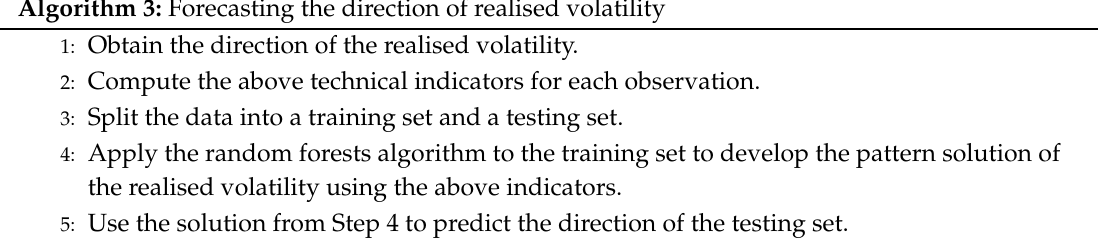
Algorithm 3: Forecasting the direction of realised volatility